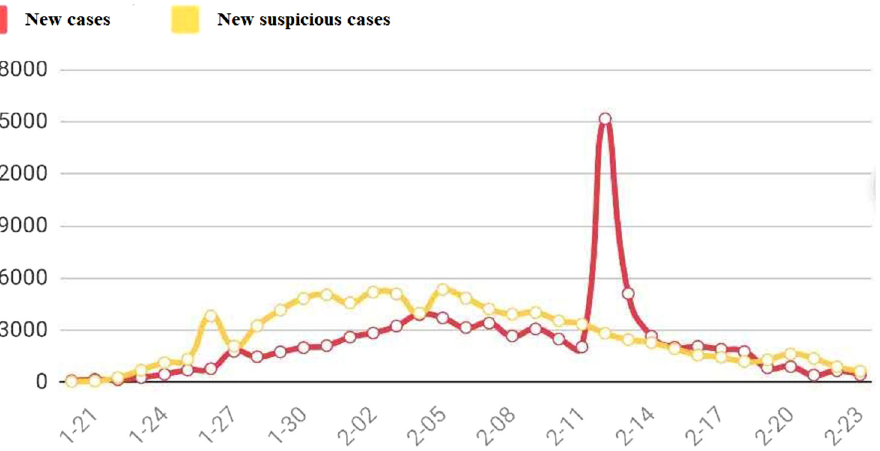
Figure 3: On February 12, 2020, a total of 15,152 new cases in China were con fi rmed COVID - 19 on one day. Among of them, a total of 13,332 new cases in Hubei Province were clinically con fi rmed using chest CT without nucleic acid